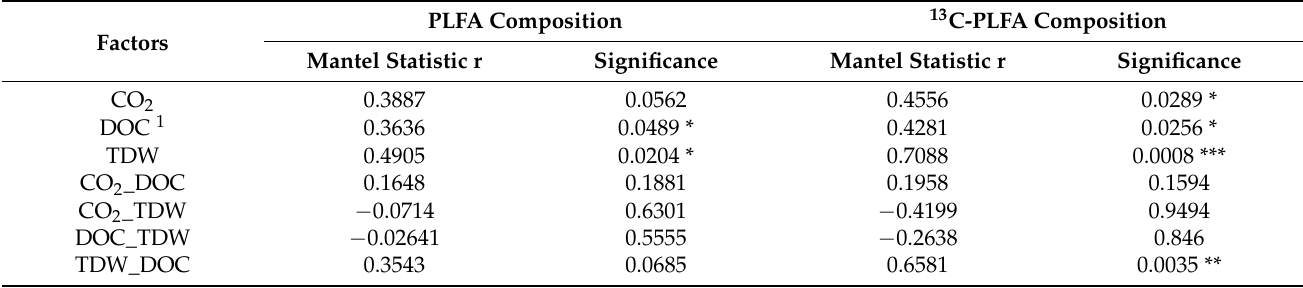
Figure 5. Principal component analysis of the 13 C − PLFA composition (mol%) of soil samples under various CO 2 treatments during the 15-day labeling experiment. Values in parentheses on the axis labels indicate the percentage variation accounted for by each axis. 400:400 µ mol · mol − 1 CO 2 treatment; 800:800 µ mol · mol − 1 CO 2 treatment. Table 2. Mantel tests between PLFA or 13 C-PLFA and environmental factors under 400 and 800 µmol·mol −1 CO 2 treatments.